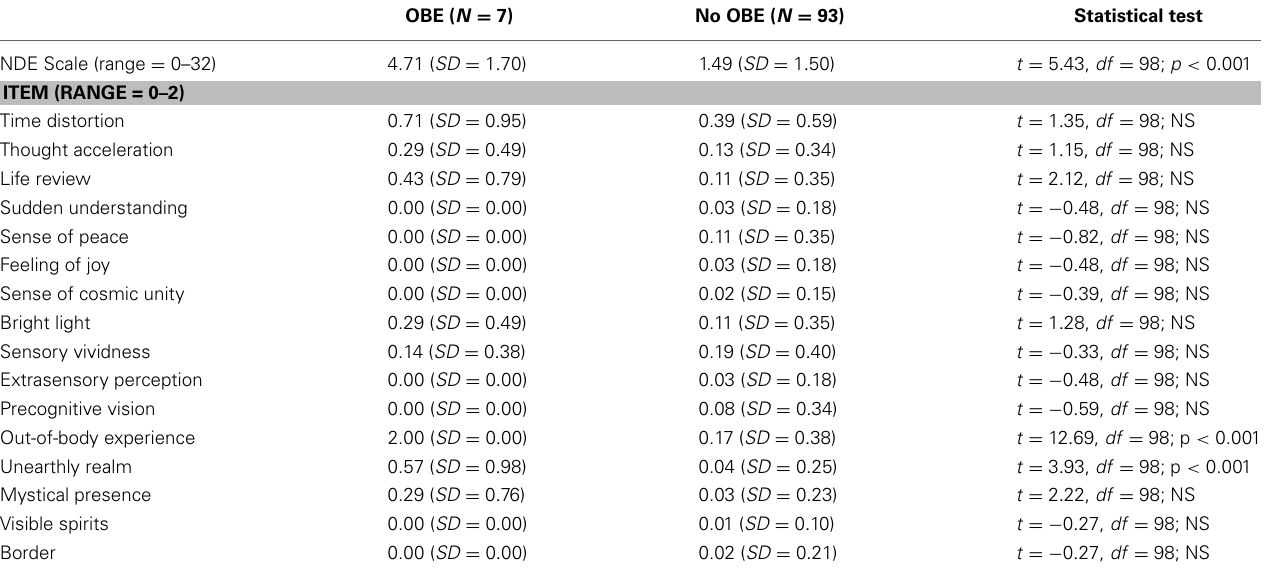
Table 3 | NDE Scale scores of patients with and without out-of-body experiences (OBEs).